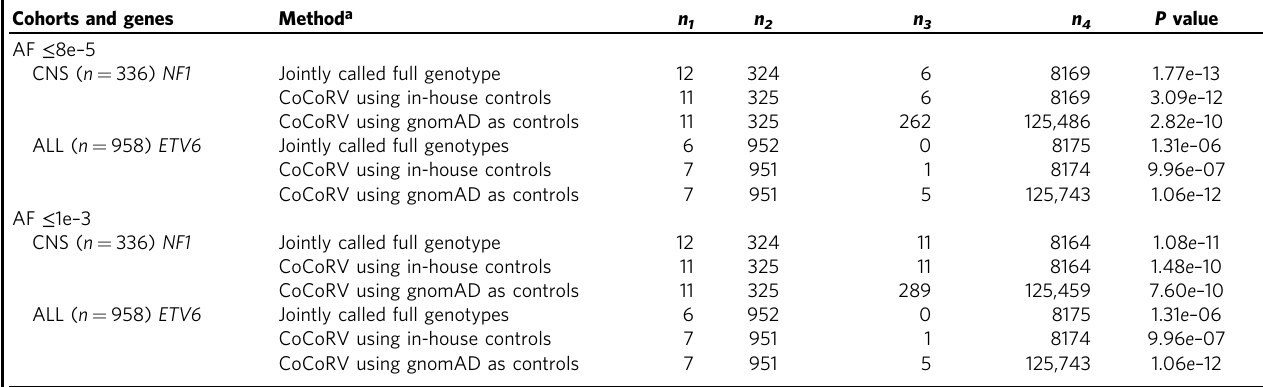
Table 2 Statistics of the top genes by using different methods and alternate allele frequency thresholds.